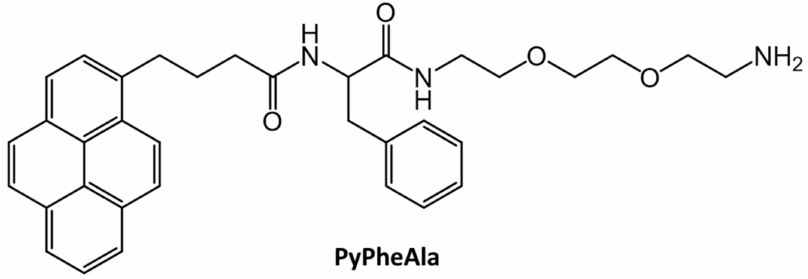
Figure 29. Molecular structure of